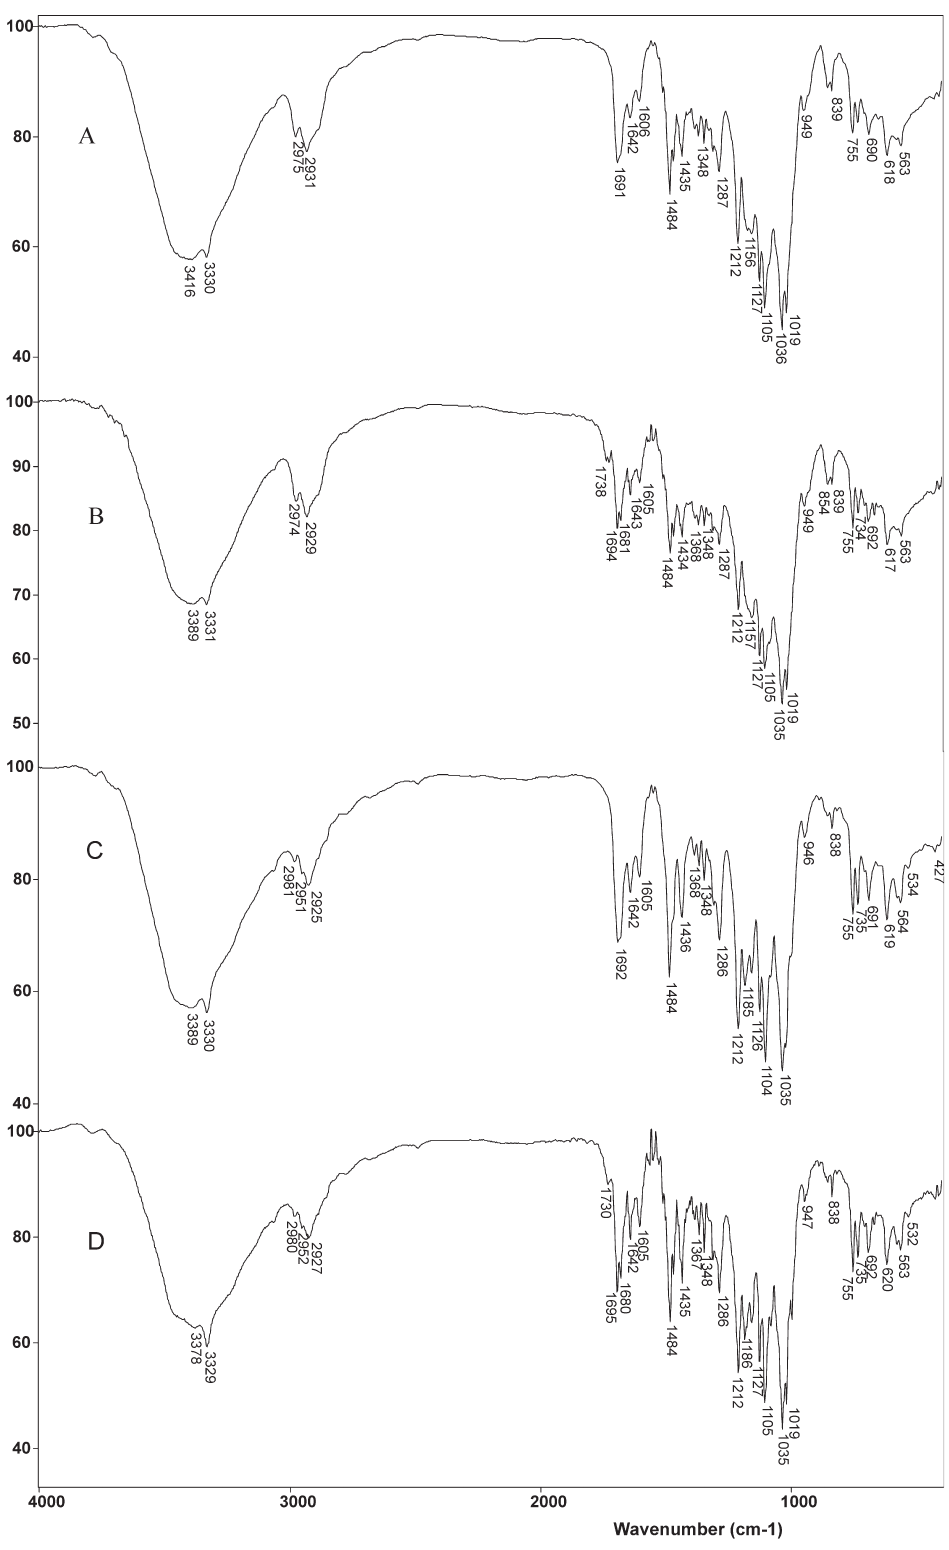
Figure 7. FTIR spectra of complex of amlodipine besylate with β-cyclodextrin non-irradiated (A) and irradiated by visible light during 8 days (B), complex of amlodipine besylate with 2-hydroxypropyl-β-cyclodextrin non-irradiated (C) and irradiated by visible light during 8 days